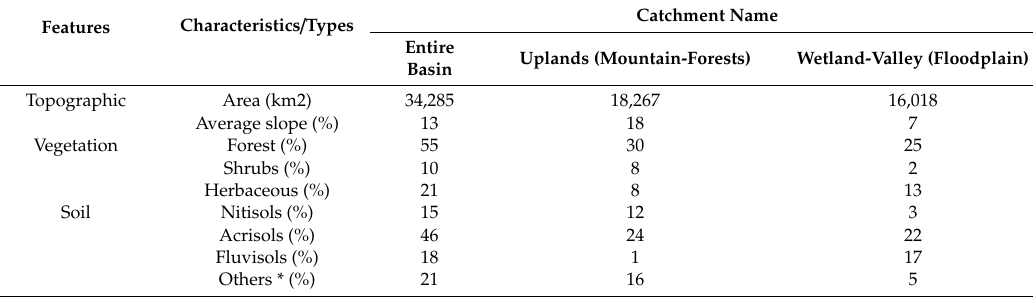
Table 2. The catchment characteristics in the Kilombero Valley (KV) river basin. Vegetation information was extracted from the 300 m spatial resolution global land cover map for the year 2015 provided by the European Space Agency (ESA) Climate Change Initiative (CCI), and soil information was extracted from the global harmonized soil database provided by Food and Agriculture Organization (FAO).